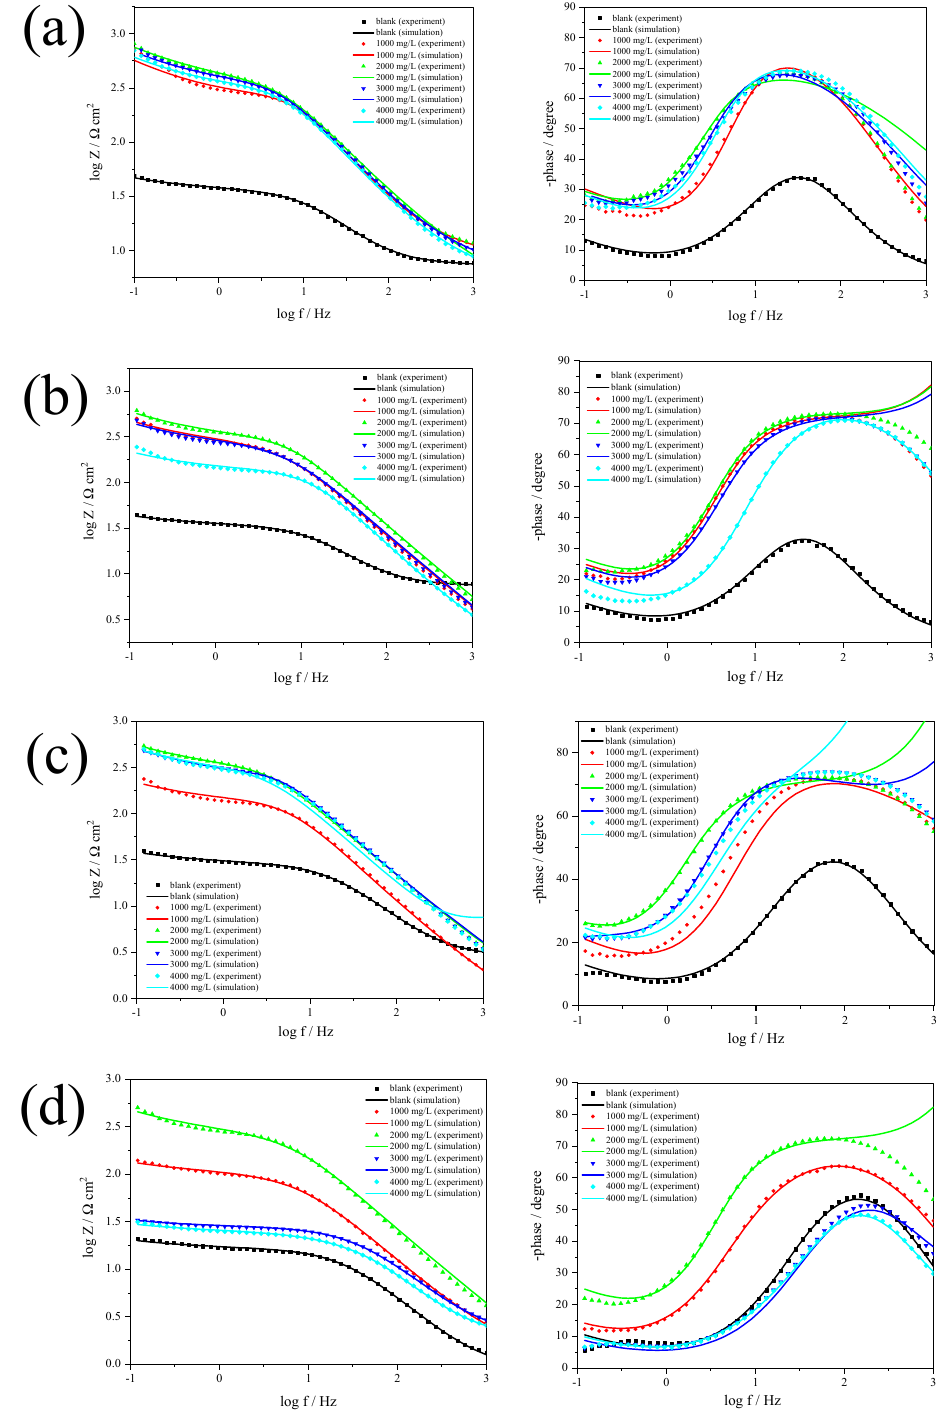
Figure 7. Bode plots for 304 SS with and without inhibitor in 0.5 M ( a ), 1.0 M ( b ), 1.5 M ( c ), and 2.0 M H 2 SO 4 solution ( d ). Bode modulus (left) and Bode phase (right).